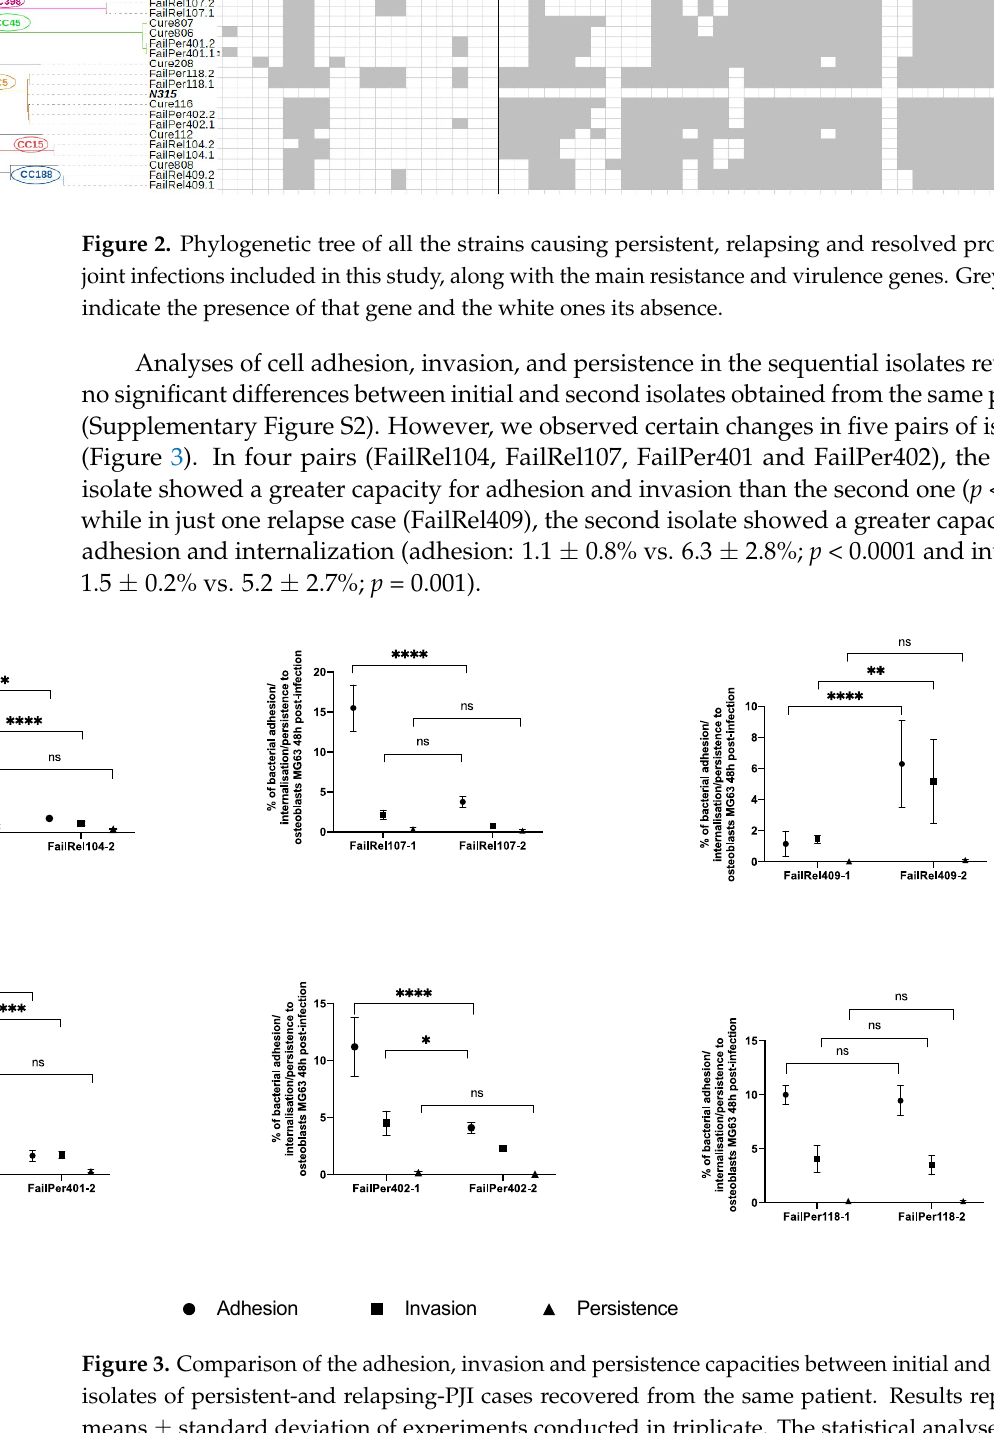
6 of 14 Figure 1. Adhesion ( A ), invasion ( B ) and persistence intracellular assay ( C ) on MG63 osteoblasts of PJI S. aureus isolates. All results are expressed as the percentage of the initial strain ( ≈ 5×106). The horizontal bars denote the median with the interquartile range derived from three independent ex- periments in triplicate for each clinical isolate. Statistical analysis were performed by using the Mann–Whitney U-test (* p < 0.05; *** p < 0.001. Figure 2 shows the phylogenetic tree of all isolates causing persistent, relapsing, and resolved PJIs together with the main resistance and virulence genes. The isolates were grouped according to CC and MLST similarity, forming two clearly differentiated clusters. Supplementary Table 2 shows the virulence genes of all strains causing PJI according to clinical evolution. All isolates harbored genes encoding microbial surface components rec-